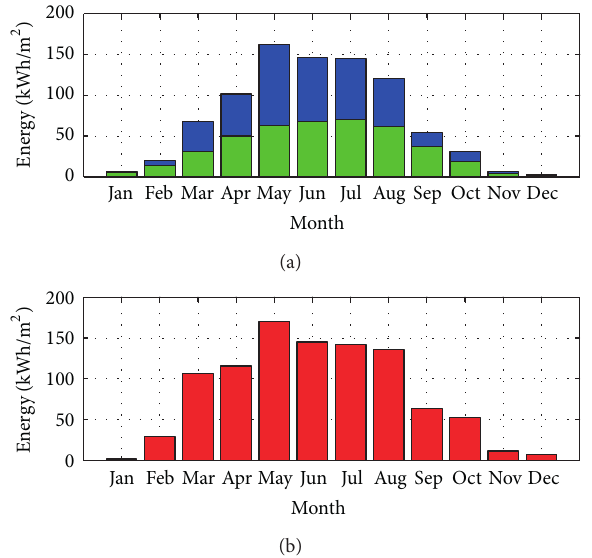
Figure 9: Monthly solar energy received at the TUT solar PV power station research plant during its first year of operation (August 2011 to July 2012): the blue bars on top graph correspond to the global solar energy received on the horizontal plane (measured by pyranometer CMP22), the green bars on top graph represent the diffuse solar energy on the horizontal plane (measured by pyranometer CMP21 combined with the shadow ring) and the red bars at the bottom graph correspond to the global solar energy received on the plane of modules (measured by the SPLite2 sensor